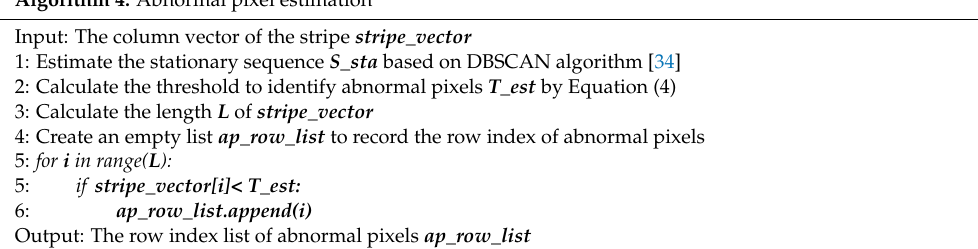
Algorithm 4. Abnormal pixel